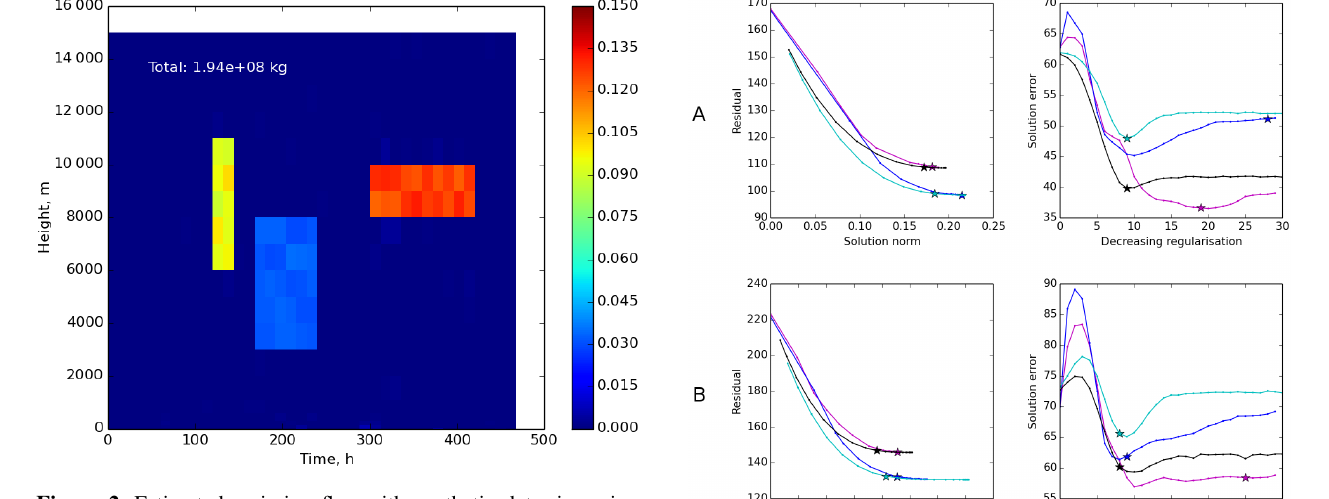
Figure 2. Estimated emission flux with synthetic data: inversion results for case B in Fig. 1, assuming a perfect forward model.